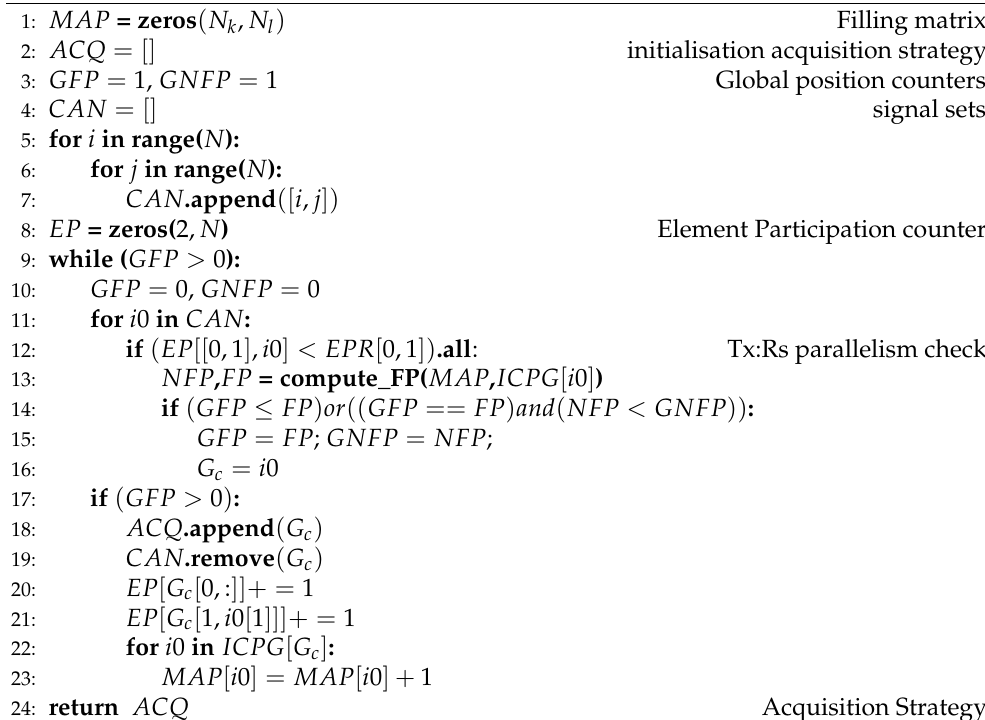
Algorithm 2 Algorithm for selecting the acquisition strategy( ACQ